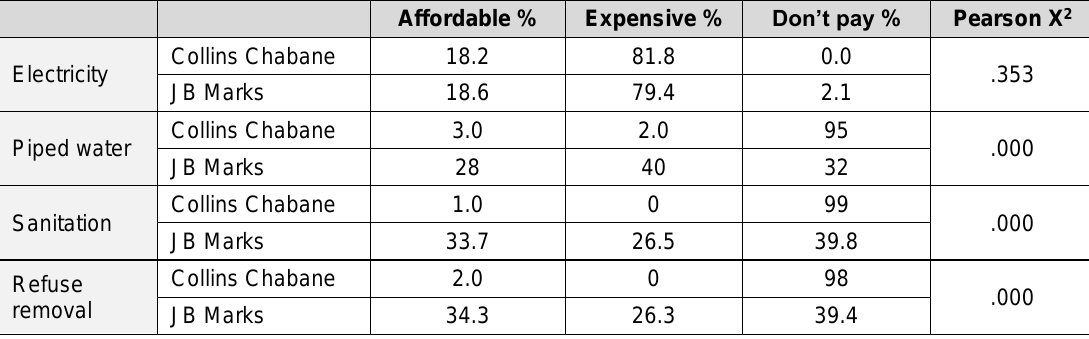
Table 6: Views on the affordability of municipal services Affordable % Expensive % Don’t pay % Pearson X